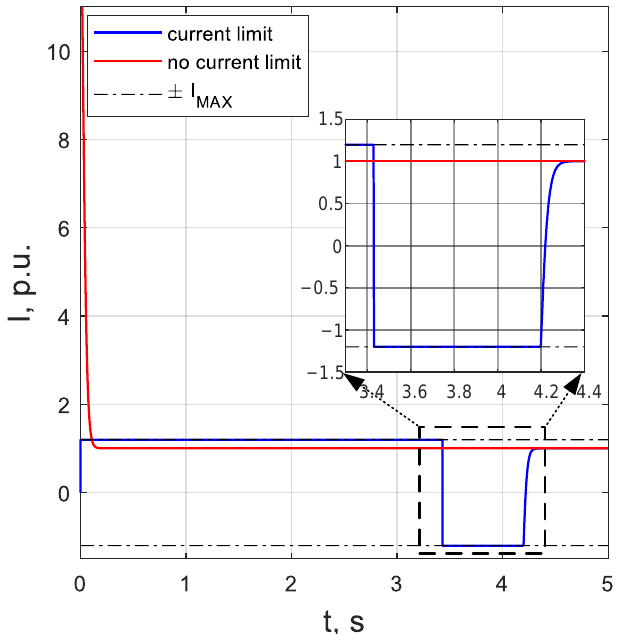
Figure 7. Current amplitude curves for different systems with the same arbitrary initial operation point ( SEP + 0.44 π , 0 ) , red curve: no current limit system; blue curve: current limit system. The current amplitude of the current-saturated system (blue curve), on the other hand, will experience a longtime interval taking on negative values before the active returns to 1.0 p.u. if the operation point moves from left to right towards the